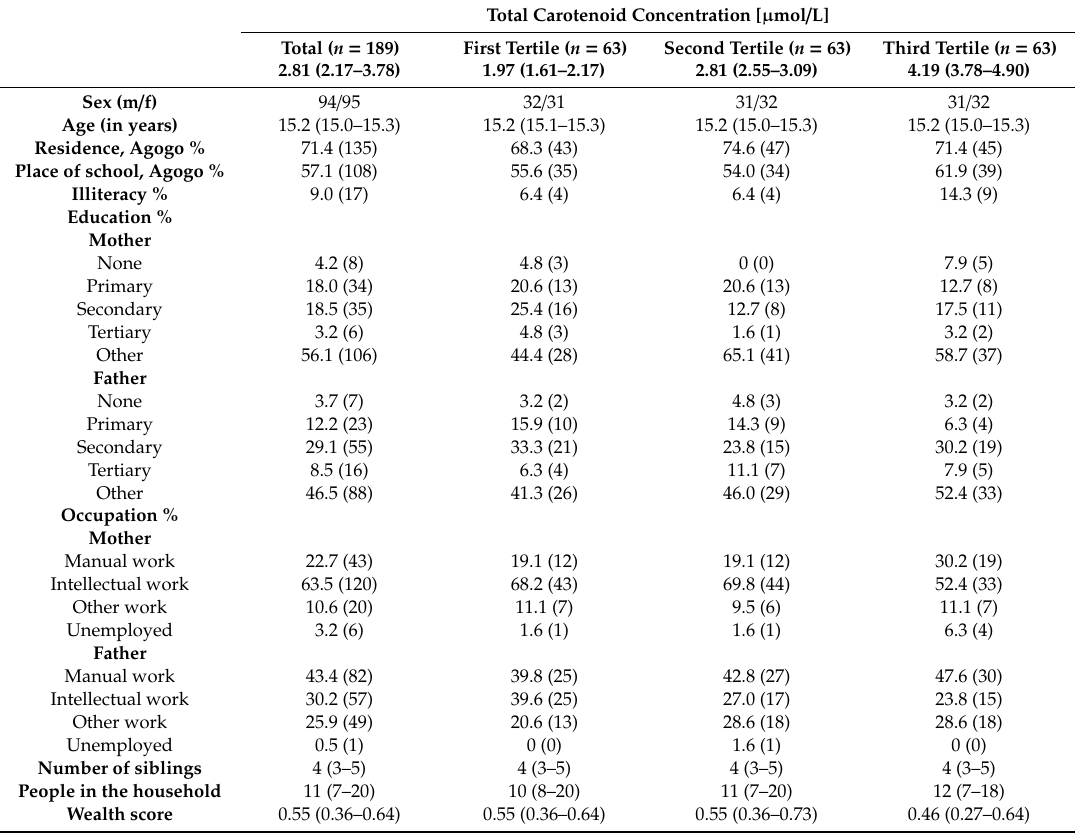
Table 1. Socio-demographic characteristics of the study participants across tertiles of plasma total carotenoid